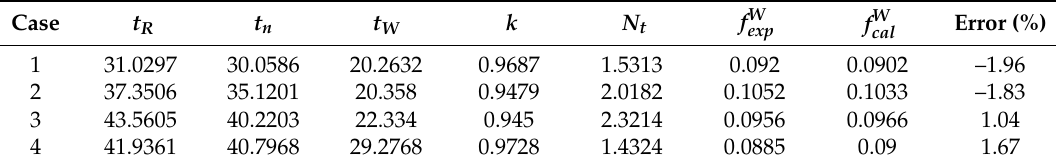
Table 2. Comparison of experimental and calculated